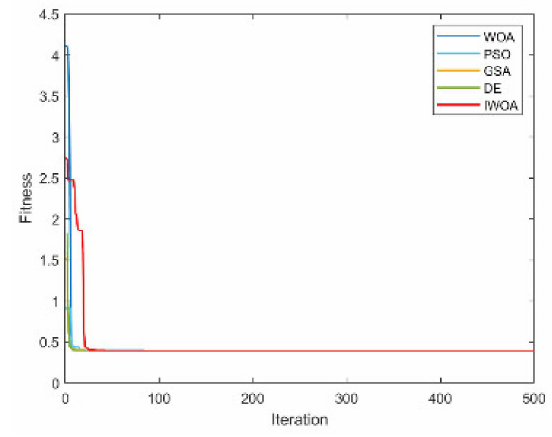
Figure A11. The convergence curve for solving